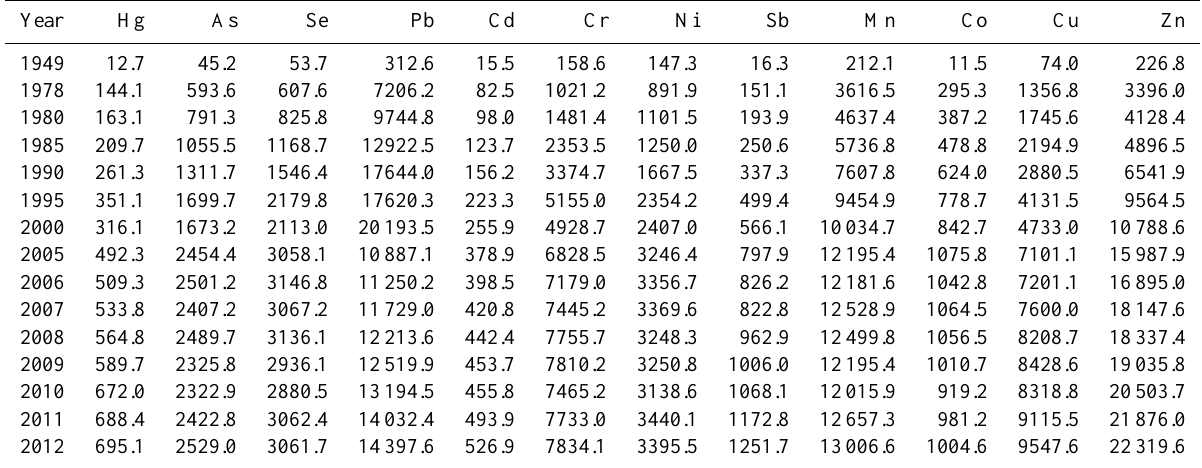
Table 2. HM emissions from primary anthropogenic sources in China, 1949–2012 (tyear − 1